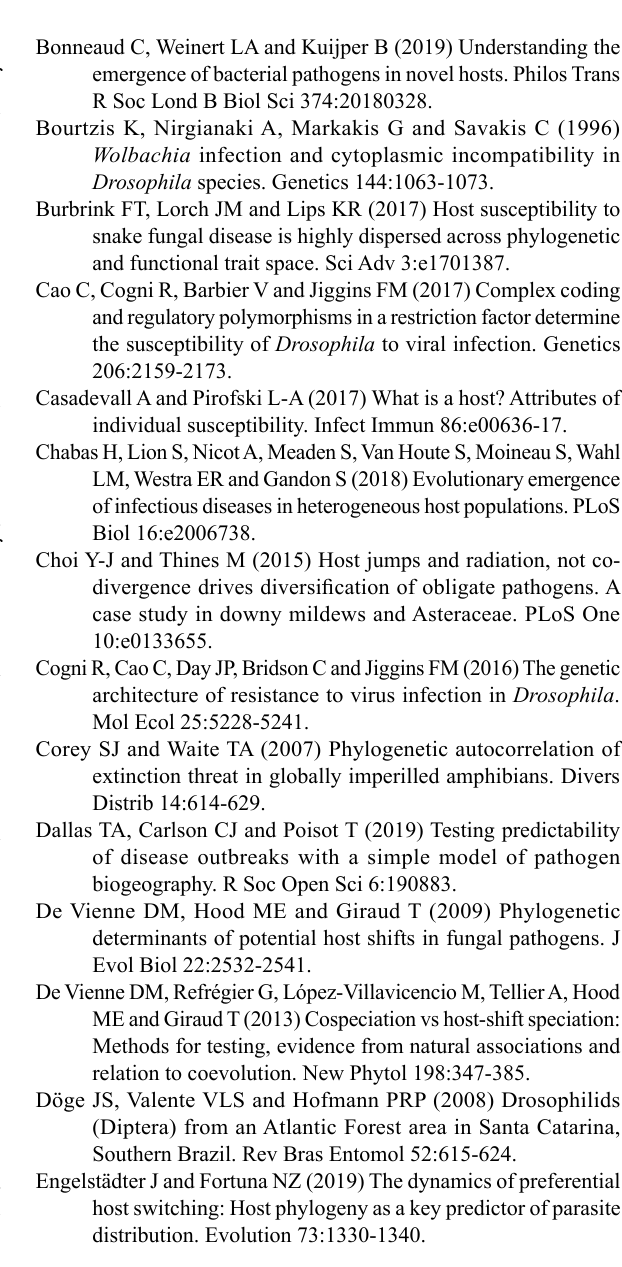
Figure 3 – Virus diversity in natural populations. (A) Fly natural populations are collected in the field and sorted into different species. (B) Nucleic acid extraction in the laboratory. (C) Metagenomic library construction. (D) Use of next generation sequencing of the libraries. (E) Bioinformatic work on virus screening based on sequence similarity. (F) Matrix showing incidence of each virus on each host